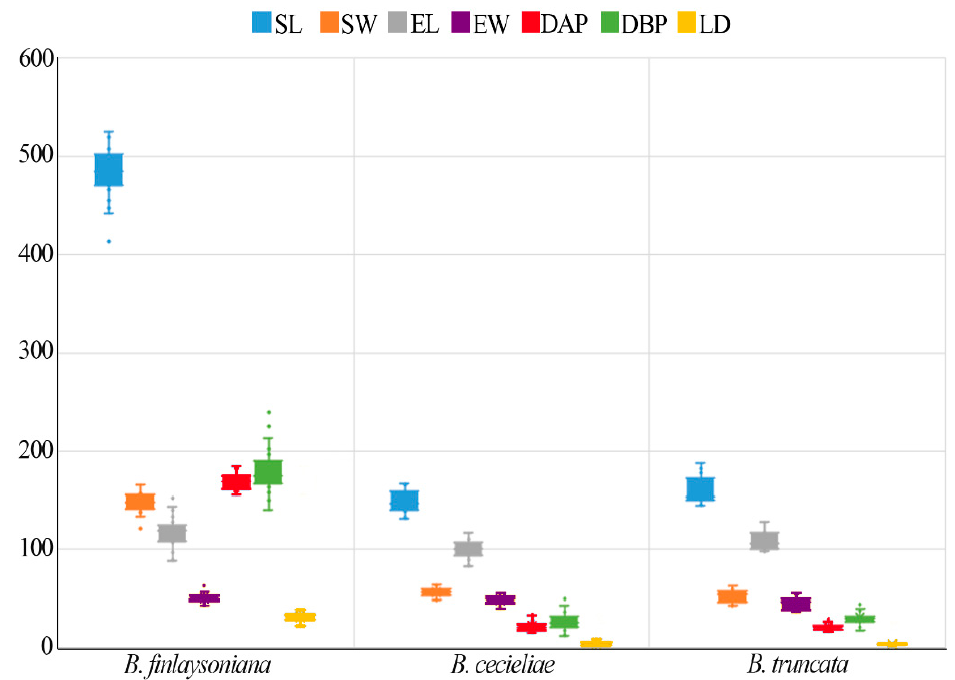
Figure 3. Box plots of measured values of the seeds of the three Bromheadia species: seed length (SL), seed width (SW), embryo length (EL), embryo width (EW), distance to the apical pole (DAP), distance to the basal pole (DBP), lateral distance (LD).